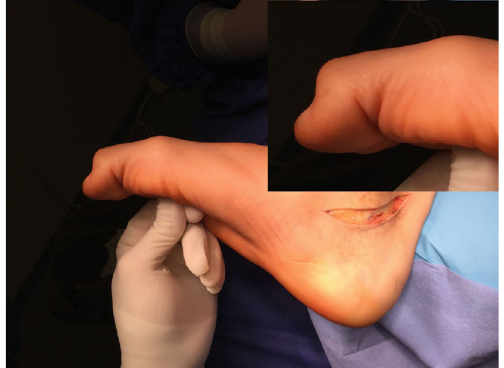
Figure 3: Preliminary suture to keep the hallux in neutral fl